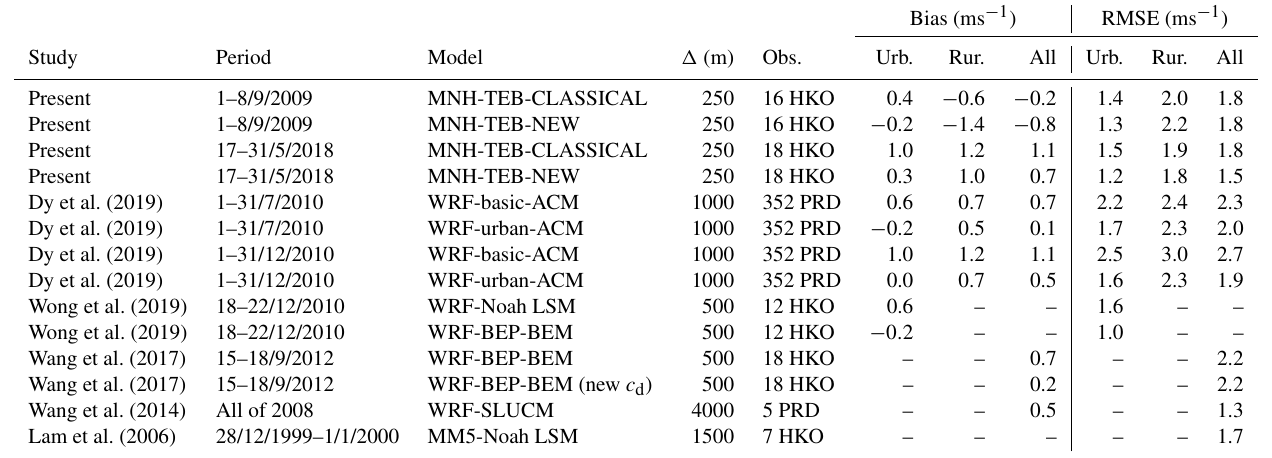
Table 5. Same as Table 3 but for wind